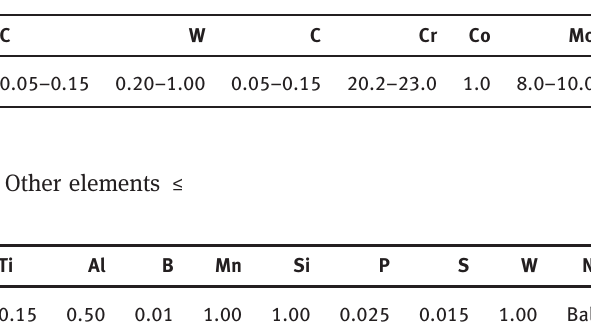
Table 1: Chemical compositions of GH3536 nickel-based alloy (mass fractions